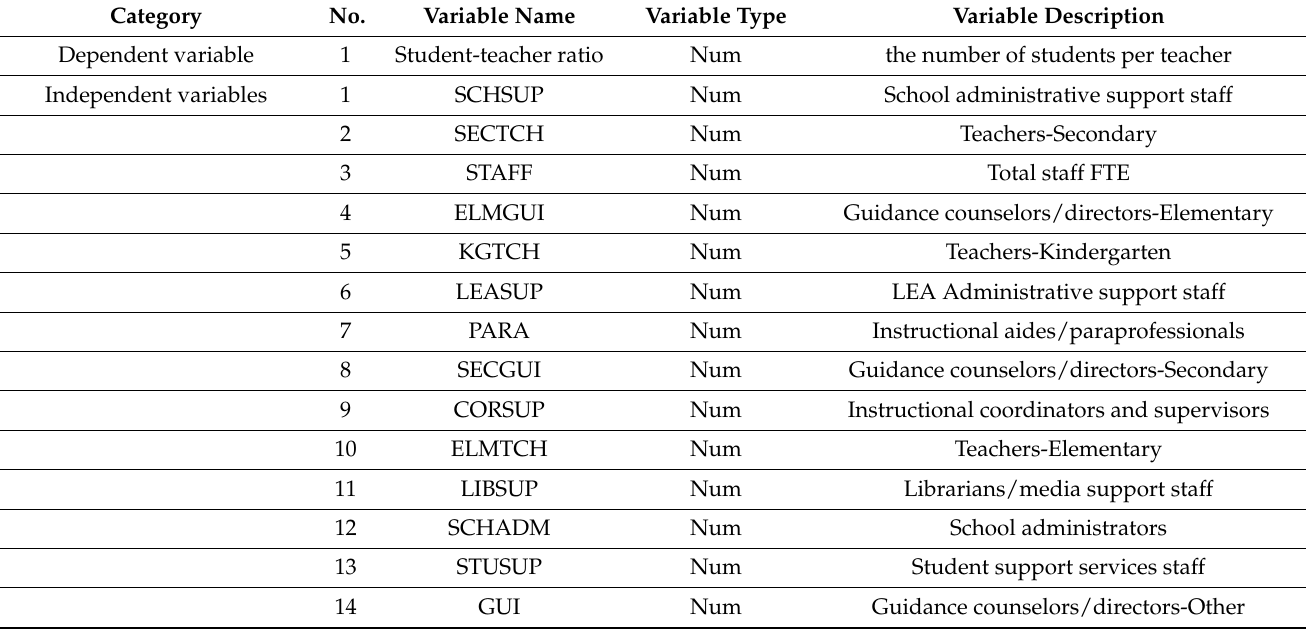
Table 1. List of variables from CCD tabular